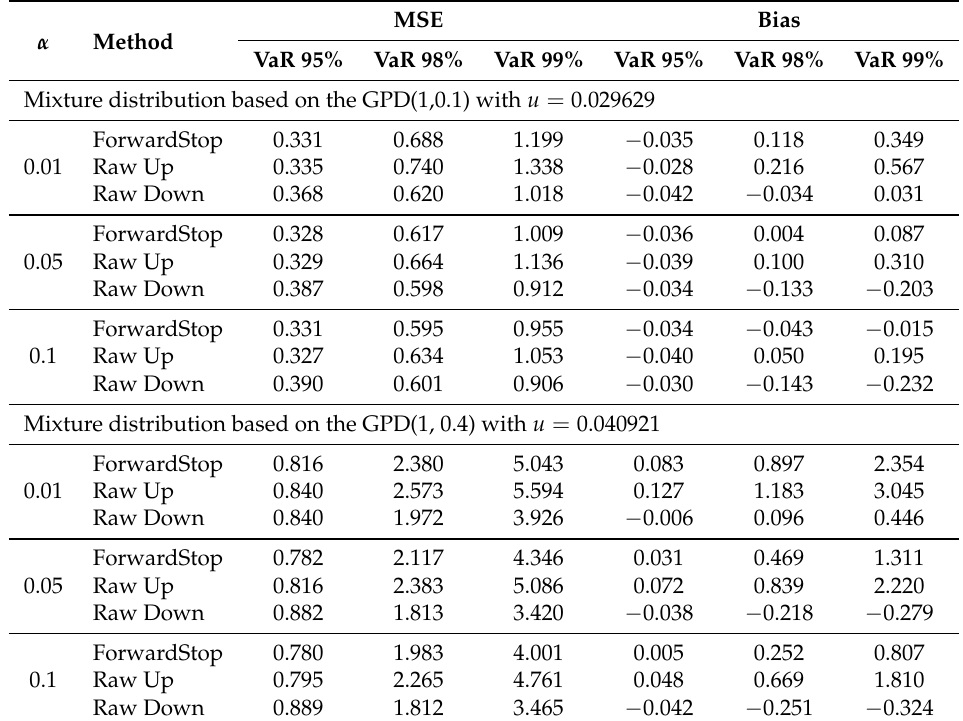
Table 2. Value at risk (VaR) estimation under the mixture